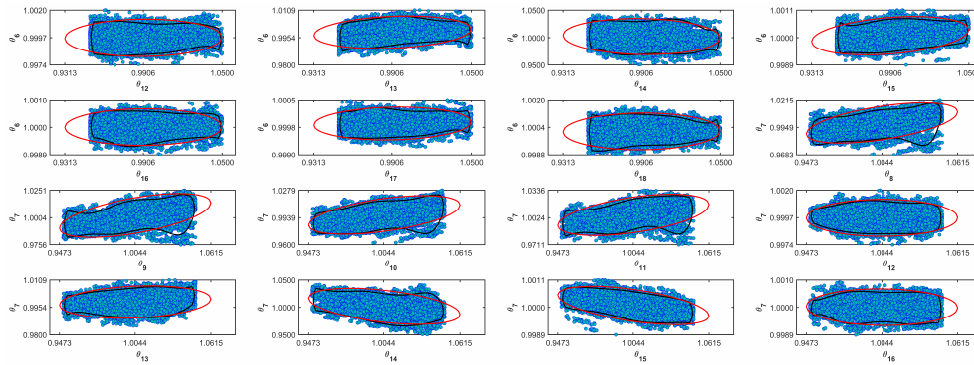
Figure A6. Coverage regions of parameters 06: (—) Gaussian region; (—) Possolo [33]